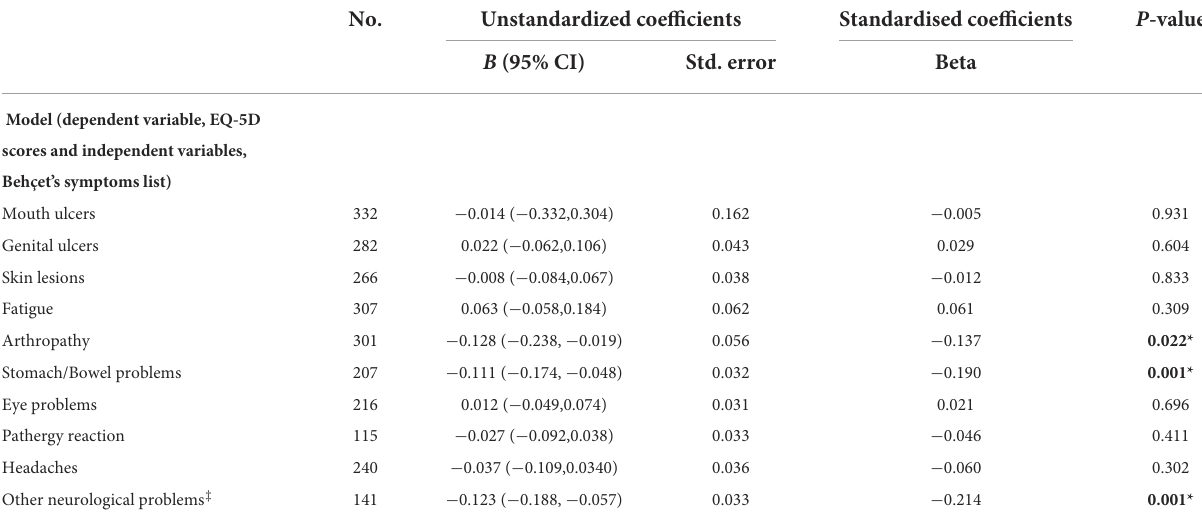
TABLE 2 The impact of BS symptoms on EQ-5D index of patients who answered 2020 survey. No. Unstandardized coefficients Standardised coefficients P -value B (95% CI) Std. error Beta Model (dependentvariable, EQ-5D scores and independentvariables, Behçet’ssymptoms list)